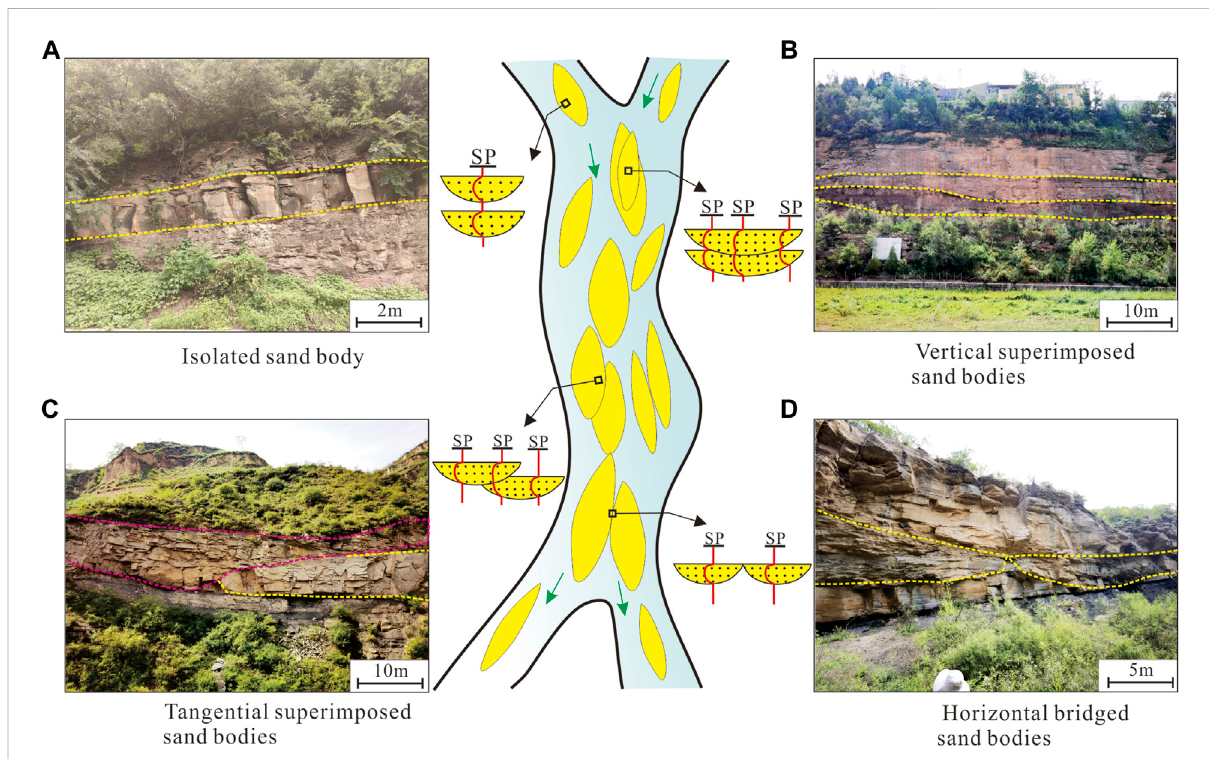
FIGURE 5 Main stacking types and outcrop characteristics of asingle sand body in thestudy area. (A) Isolatedsand body, (B) vertically superimposed sand bodies, (C) tangentially superimposed sand bodies, and (D) horizontally bridged sand bodies.